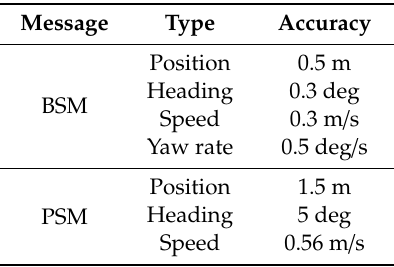
Table 7. Information accuracy for the BSM and the